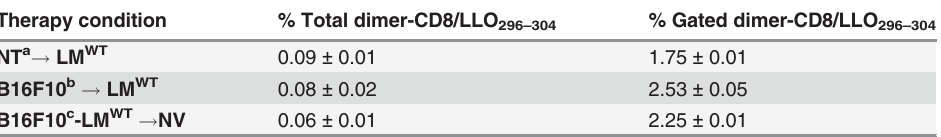
Table 3. Frequencies of LLO 296 – 304 speci fi c CD8 + T cells in spleens of B16F10 treated mice or non- treated after LM WT therapy. Therapy